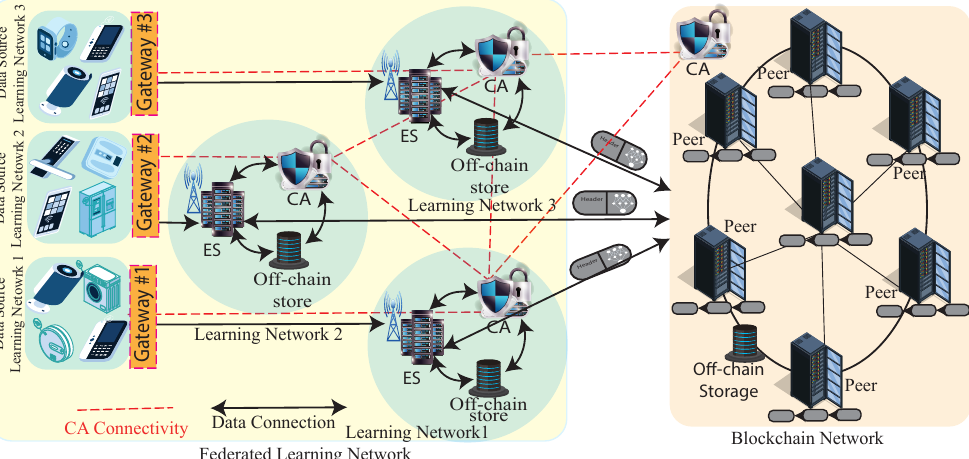
Figure 2. Blockchain-based federated learning framework for CIoT